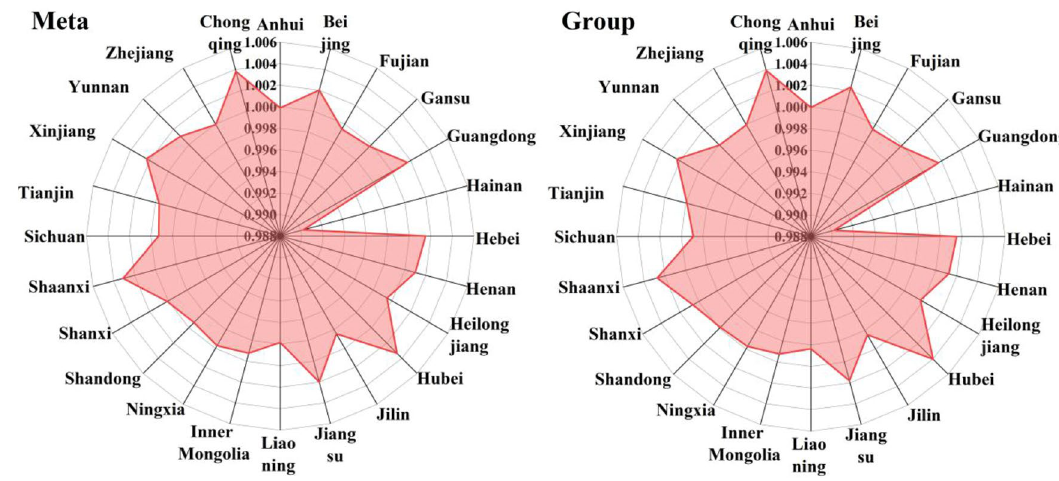
Figure 5. Average LHG in each